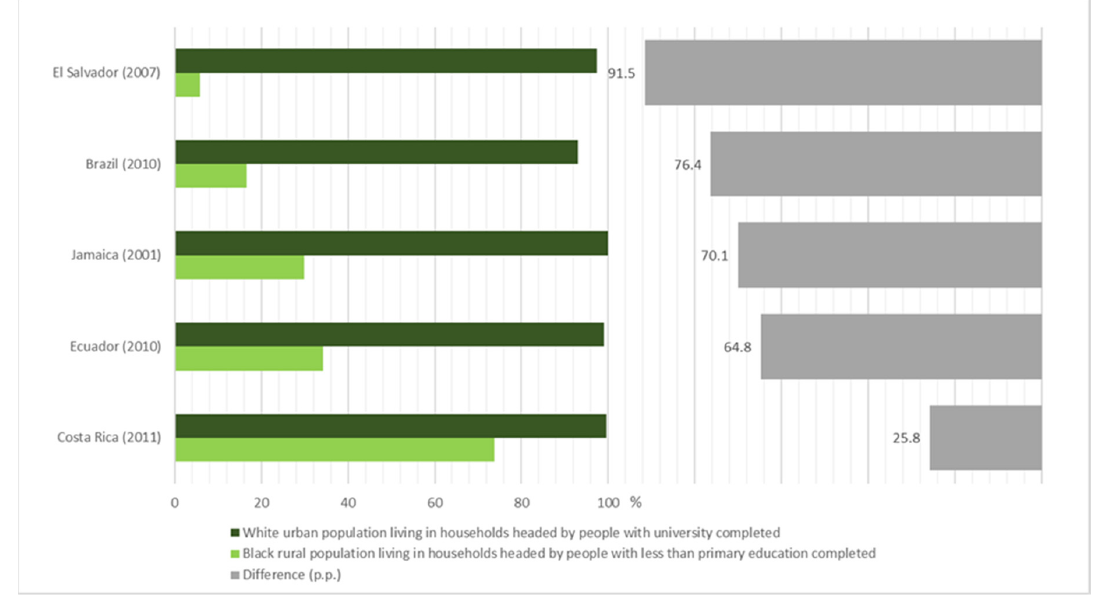
Figure 10. Access to sewerage or septic tanks by the white urban population living in households headed by persons with higher education completed in comparison with the black rural population living in households headed by persons with less than primary education completed. Source: Based on census microdata from the IPUMS-International Project [25].